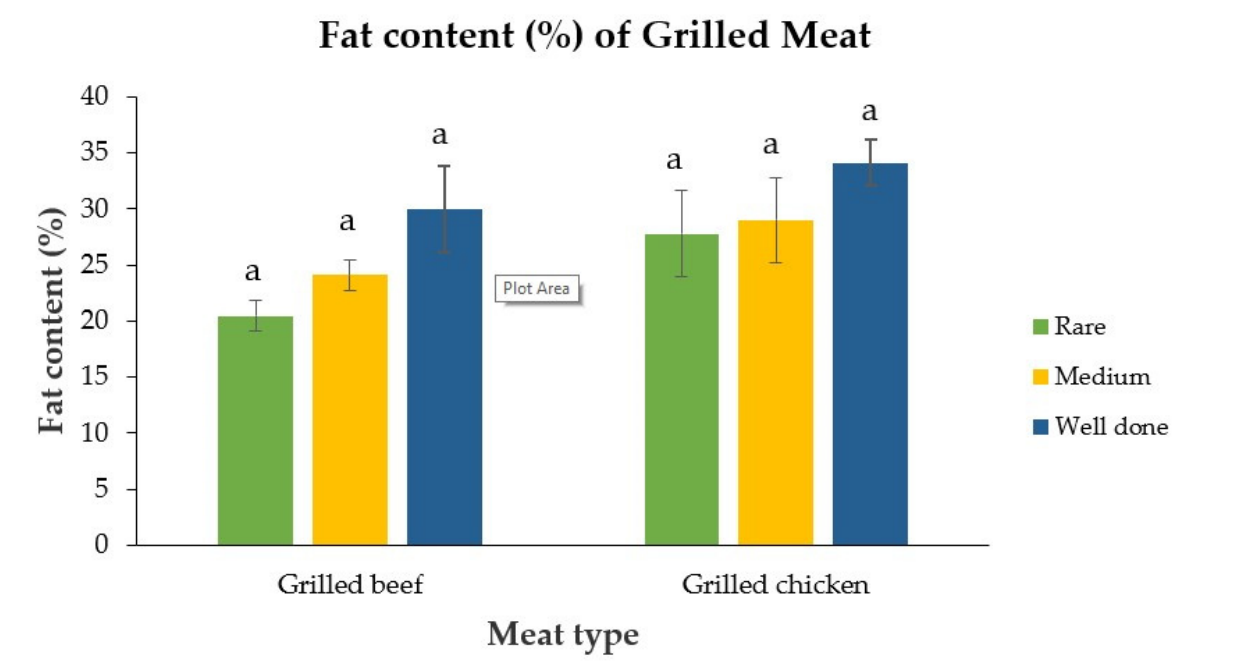
Figure 6. Fat content (%) of rare, medium and well-done grilled beef and chicken samples. Similar letter indicates no significant differences.